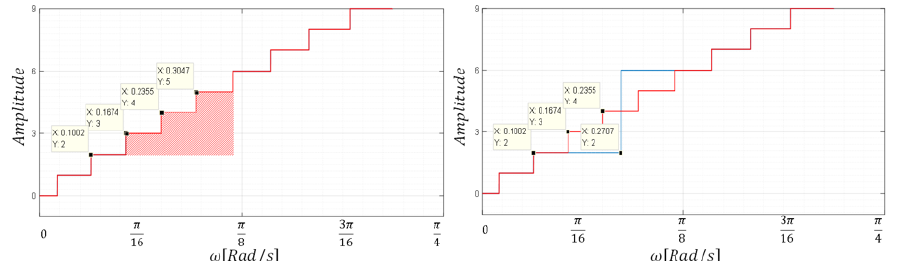
Figure 9. Area of non-replicable levels (3, 4 and 5) with S 6 in failure.